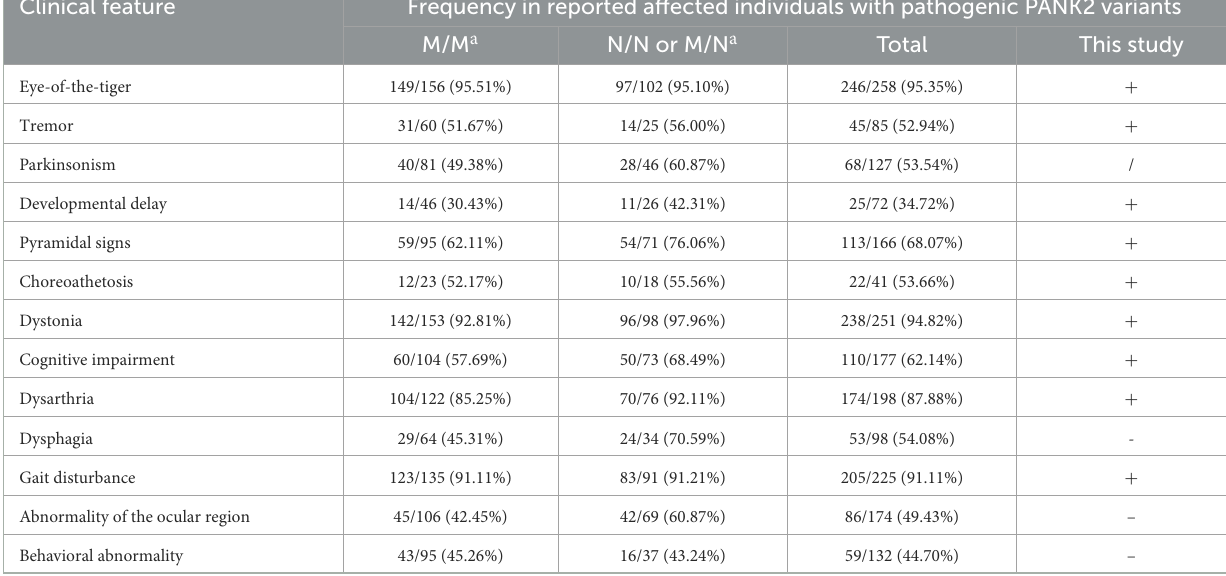
TABLE 1 Clinical features of PKAN